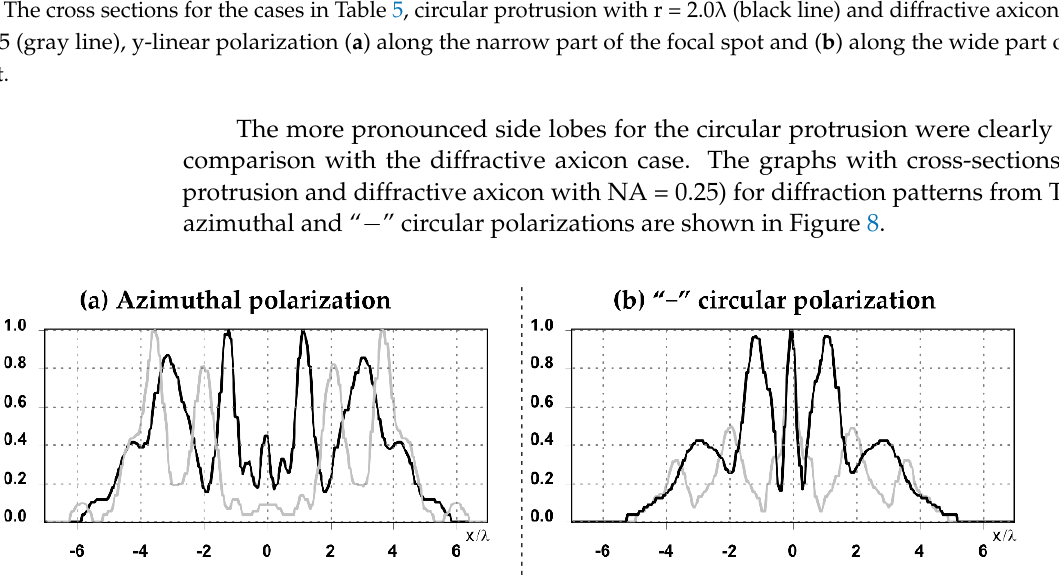
Figure 8. The cross sections for the cases in Table 5, circular protrusion with r = 2.0 λ (black line) and diffractive axicon with NA = 0.25 (gray line): ( a ) azimuthal polarization, ( b ) “ − ” circular polar- ization.